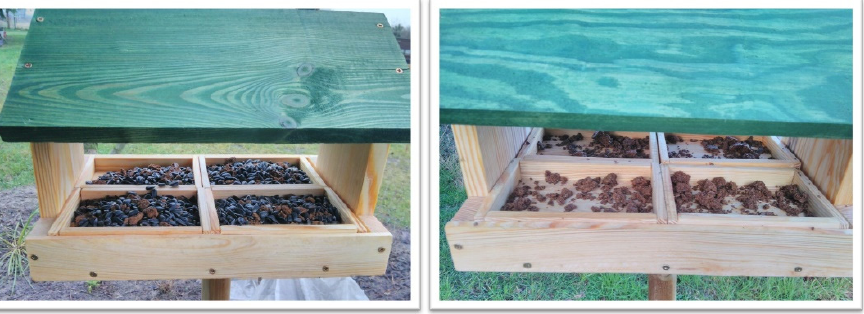
Figure 1. Experimental bird feeders used for investigating Salmonella spp. prevalence in winter in Poland. Please note the situation before ( left ) and after ( right ) providing sunflower seeds.